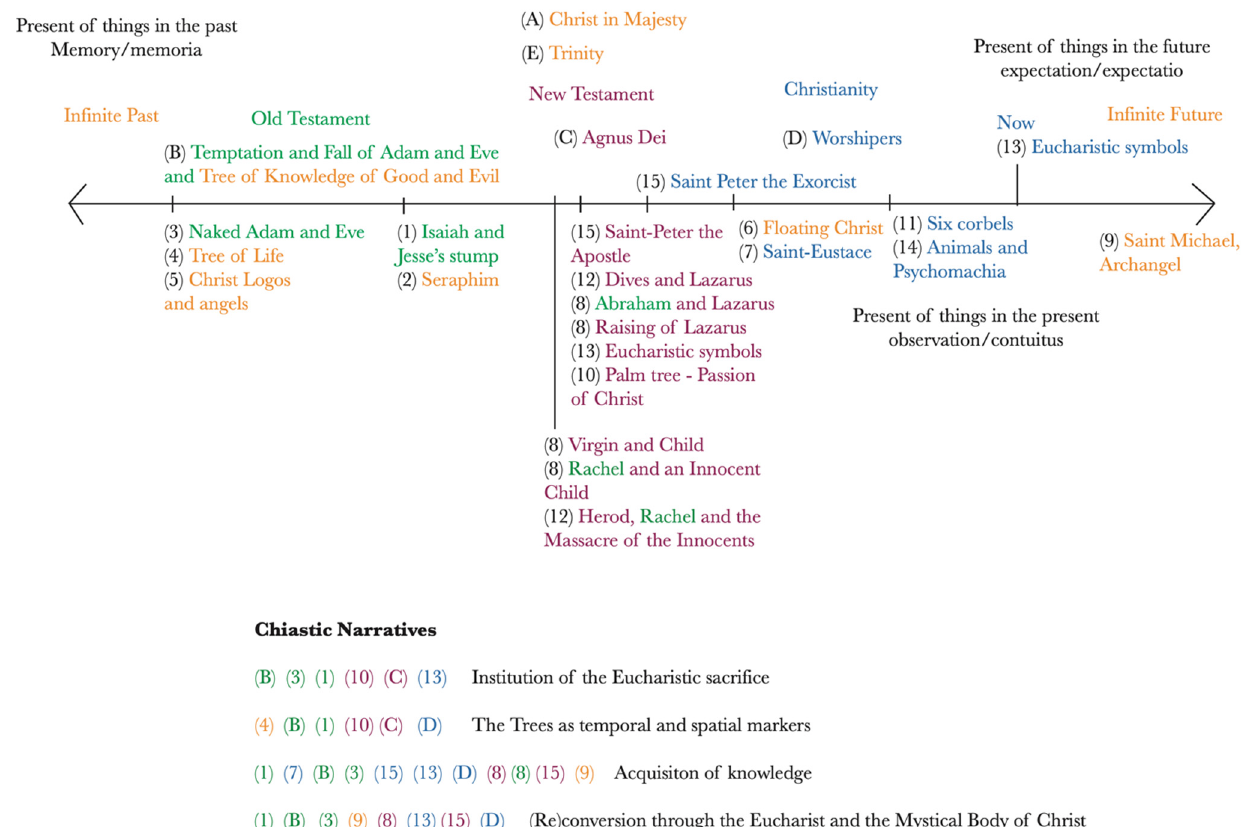
Figure 33. Saint-Martin Church, timeline and chiastic narratives.